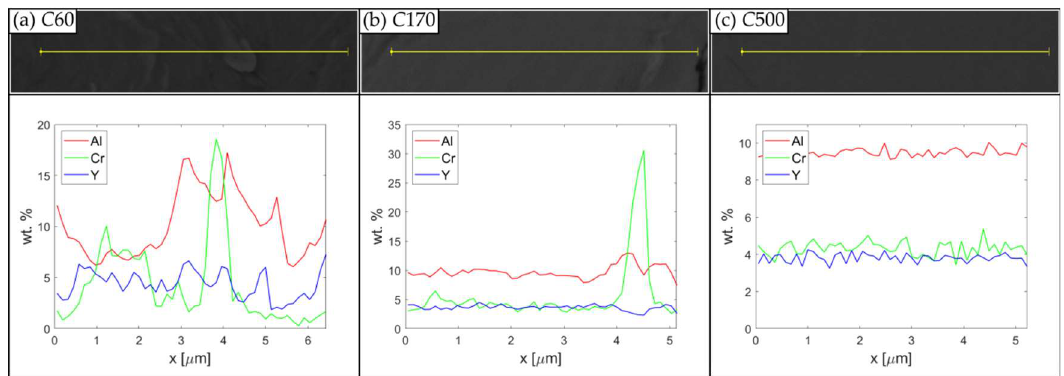
Figure 3. BSE images and corresponding EDS mapping of powder particles of ( a ) C 60, ( b ) C 90, ( c ) C 120, ( d ) W 120, ( e ) C 170, and ( f ) C 500.